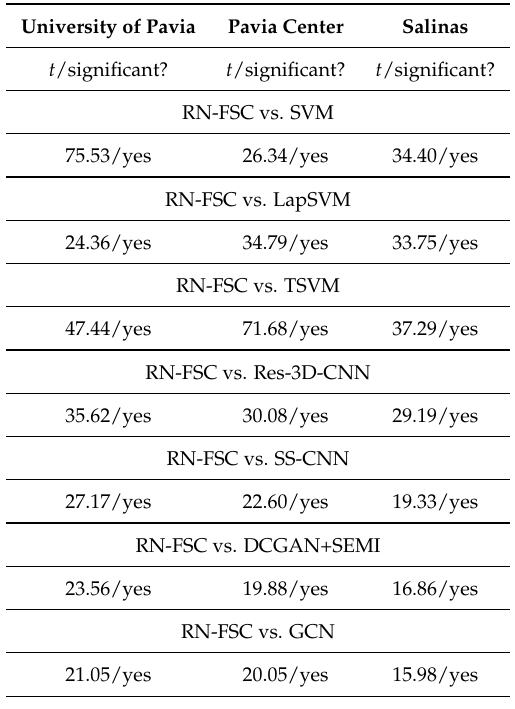
Table 10. Results of the paired t -test on three target data